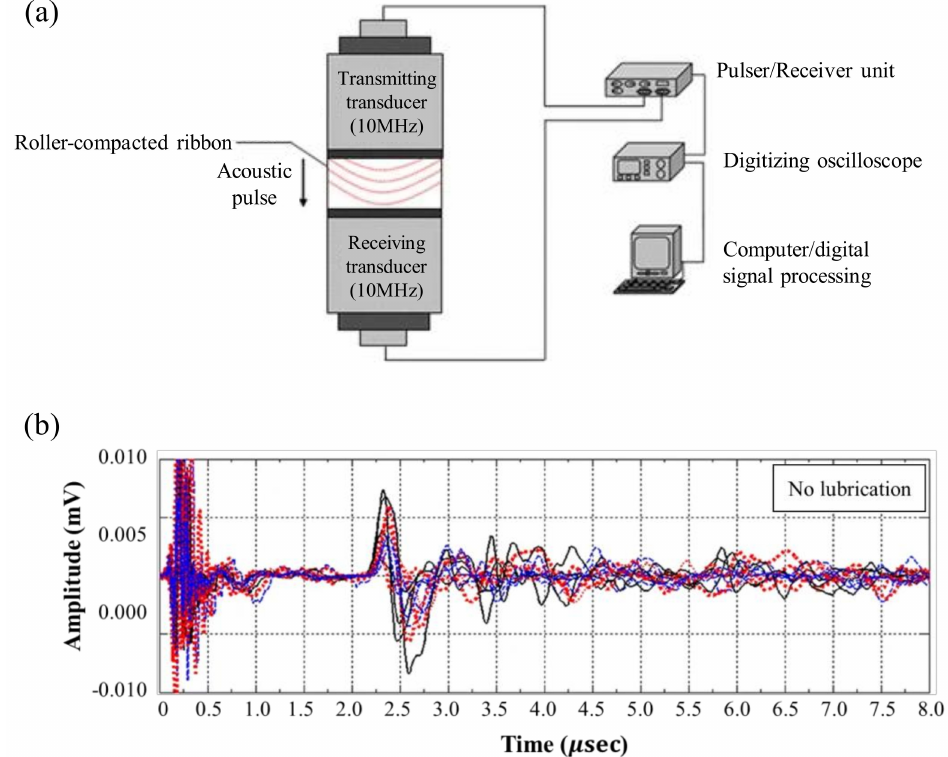
Figure 16. Application of non-destructive ultrasonic waves to predict ribbon characteristics [159]: ( a ) experimental setup; ( b ) acoustic waveforms obtained according to the position of the ribbon. Blue, black and red lines represent the scan at the upside, middle and the downside of ribbon, respectively. These results are for powder with no lubrication. The figures were slightly modified, with permission from